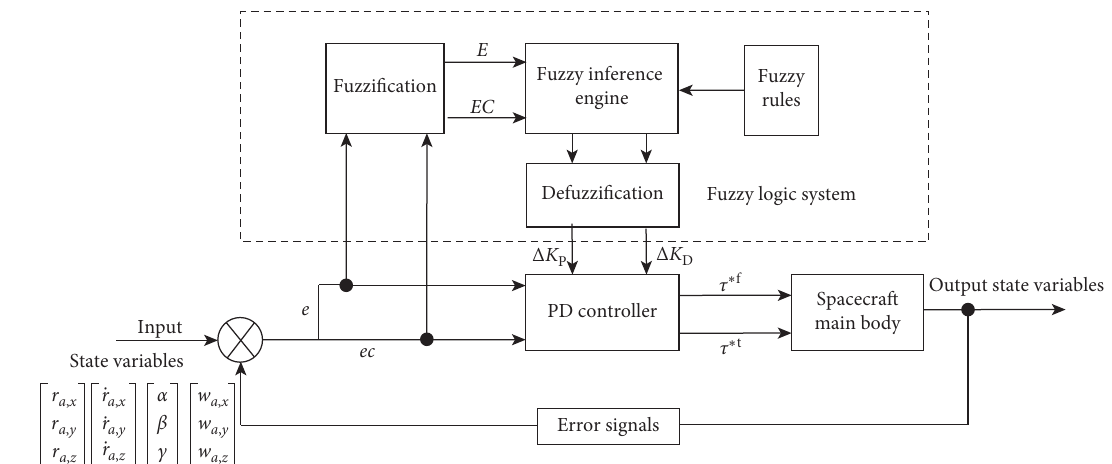
Figure 6: Schematic of the adaptive fuzzy PD control